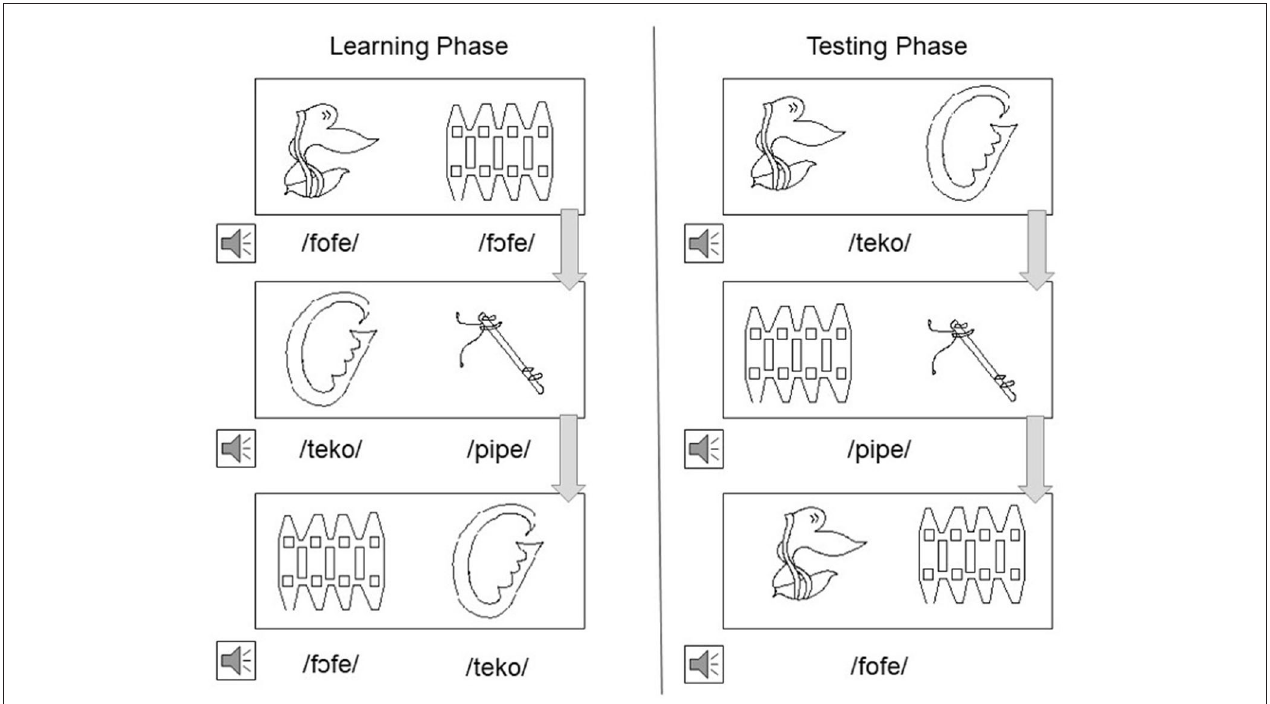
FIGURE 2 | Representation of Brazilian Portuguese learning phase and testing phase presented to participants. Arrows indicate linear order through trials; participants were first exposed to the learning phase and then the testing phase.